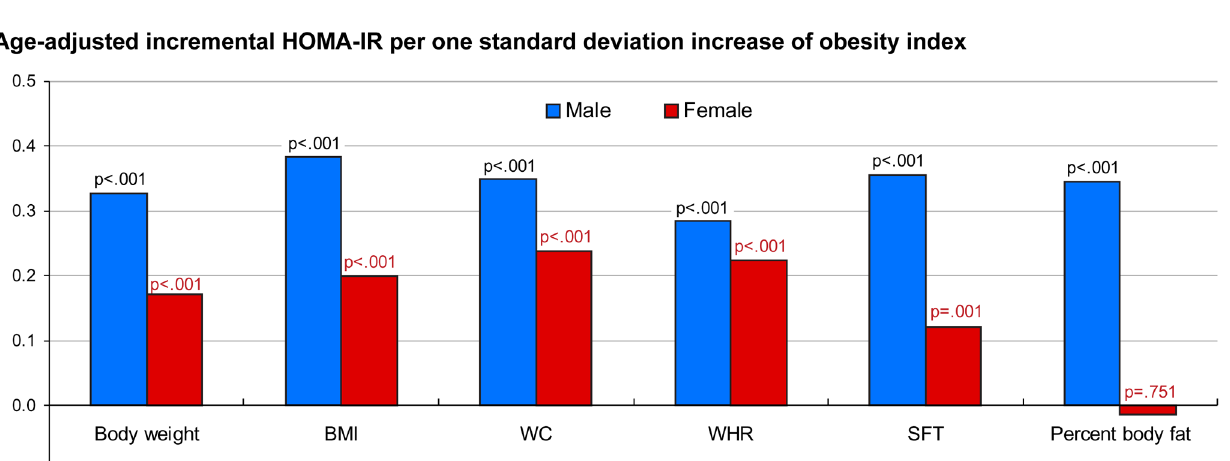
PLOS ONE | DOI:10.1371/journal.pone.0125238 May 13,